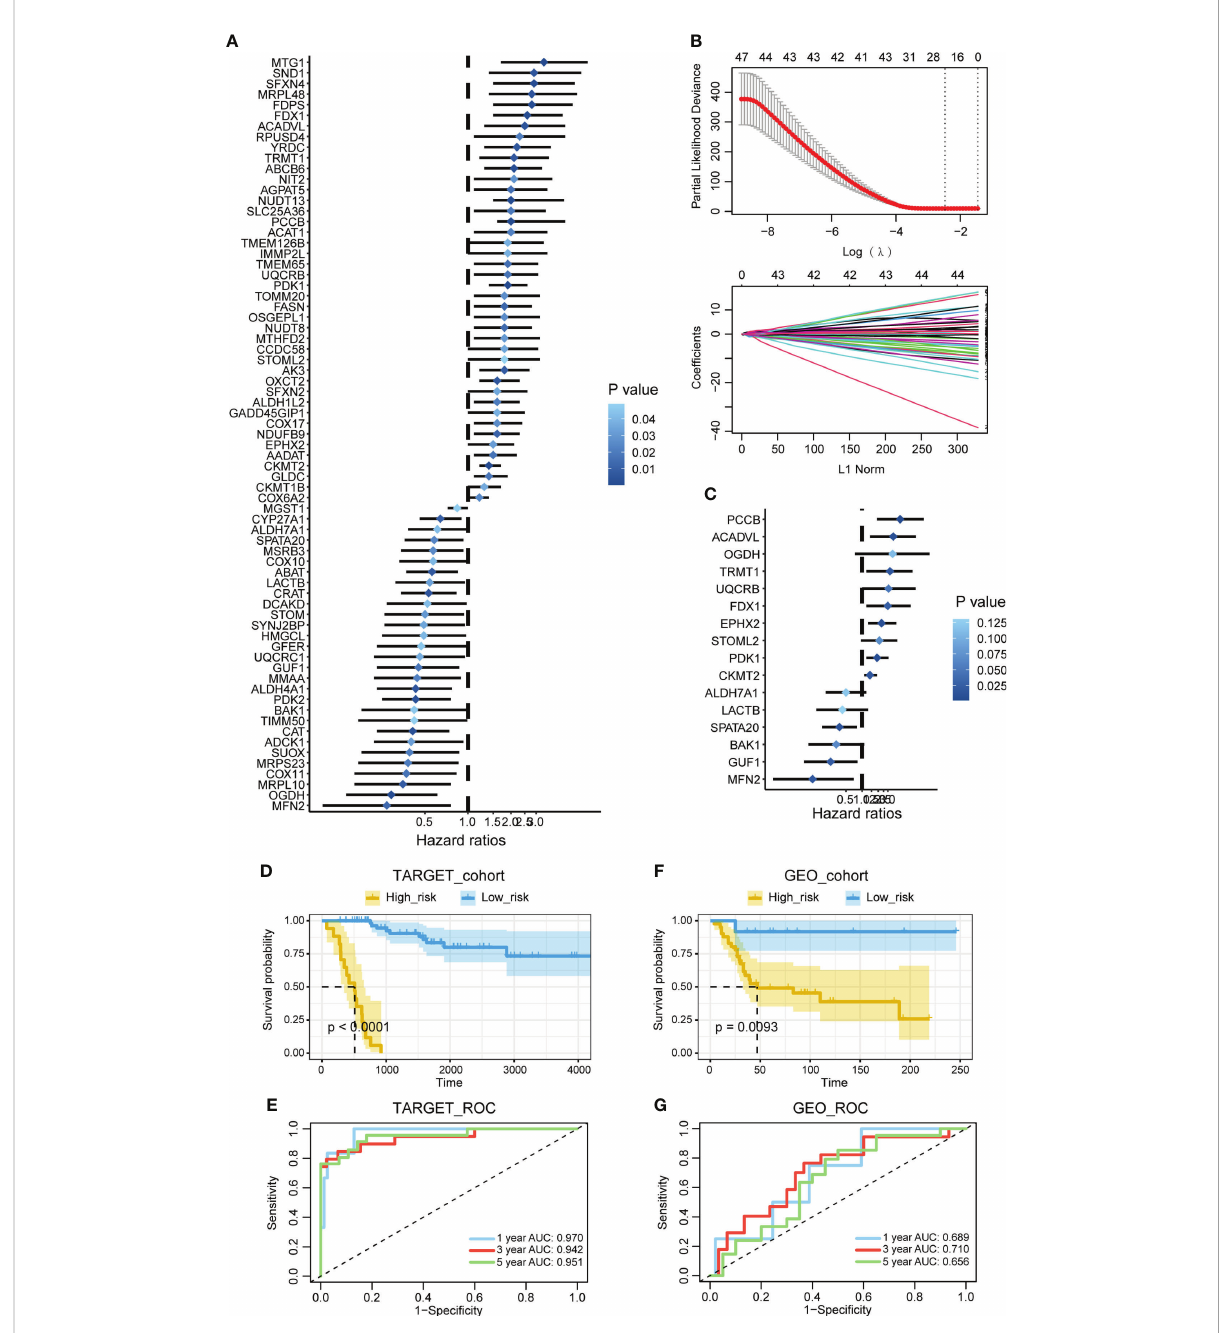
FIGURE 1 Construction of the mitochondria-related signature. (A) The univariate Cox regression analysis was performed on the mitochondria-related genes. (B) The LASSO regression analysis was performed on the prognostic mitochondria-related genes. (C) The stepwise multivariate Cox regression analysis was performed on the prognostic mitochondria-related genes. (D) Survival analysis was performed on the two mitochondria-related signature score groups in TARGET. (E) Survival analysis was performed on the two mitochondria-related signature score groups in GSE21257. (F) The 1-year, 3-year, and 5-year ROC curves of the mitochondria-related signature in TARGET. (G) The 1-year, 3-year, and 5-year ROC curves of the mitochondria-related signature in